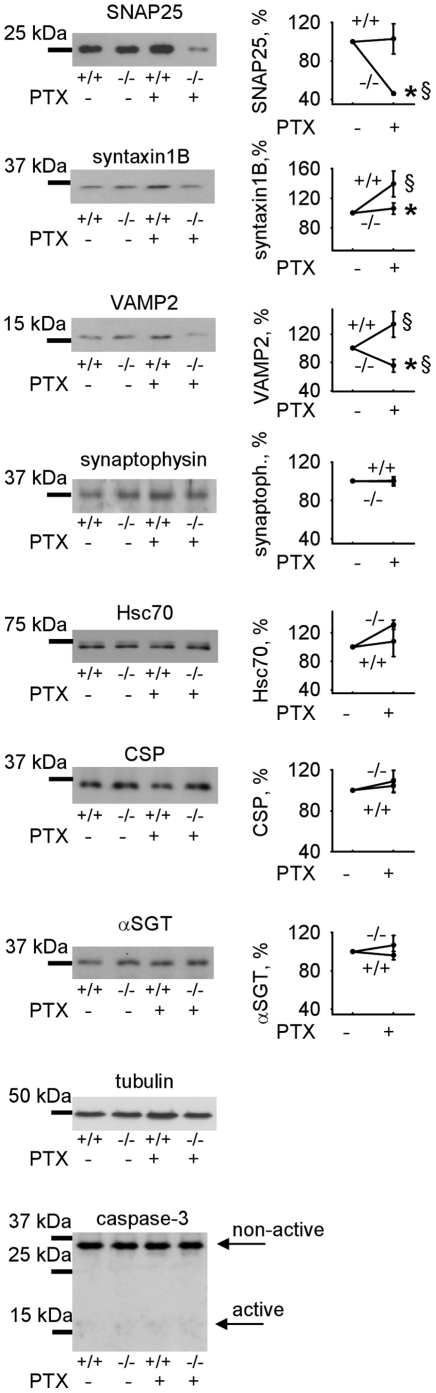
Levels of SNARE proteins are reduced in CHL1−/− versus CHL1+/+ neurons subjected to high levels of synaptic activity.CHL1+/+ and CHL1−/− cultured hippocampal neurons were stimulated with 50 µM PTX applied for 30 min. Lysates of non-treated and PTX treated neurons were probed by Western blot with the indicated antibodies. Graphs show mean optical density of the blots ± SEM (n = 6) with signals in non-treated neurons set to 100%. Note reduced levels of SNAP25, syntaxin1B, and VAMP2, but not synaptophysin in stimulated CHL1−/− versus stimulated CHL1+/+ neurons. PTX application did not induce apoptosis as indicated by unchanged levels of non-active and active caspase-3 in both genotypes. Tubulin served as a loading control. *,§ p<0.05, paired t-test (PTX stimulated CHL1−/− versus CHL1+/+ neurons (*), and PTX stimulated versus non-stimulated neurons of the same genotype (§) were compared).